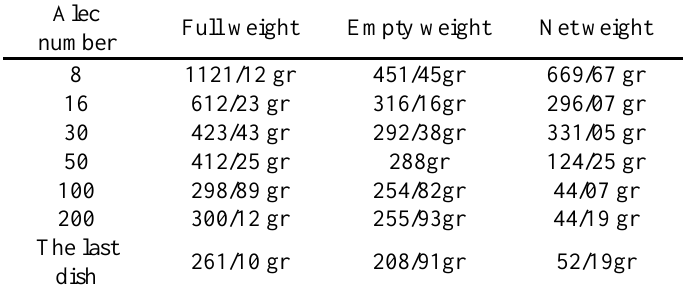
Table 3. Sand granulation table